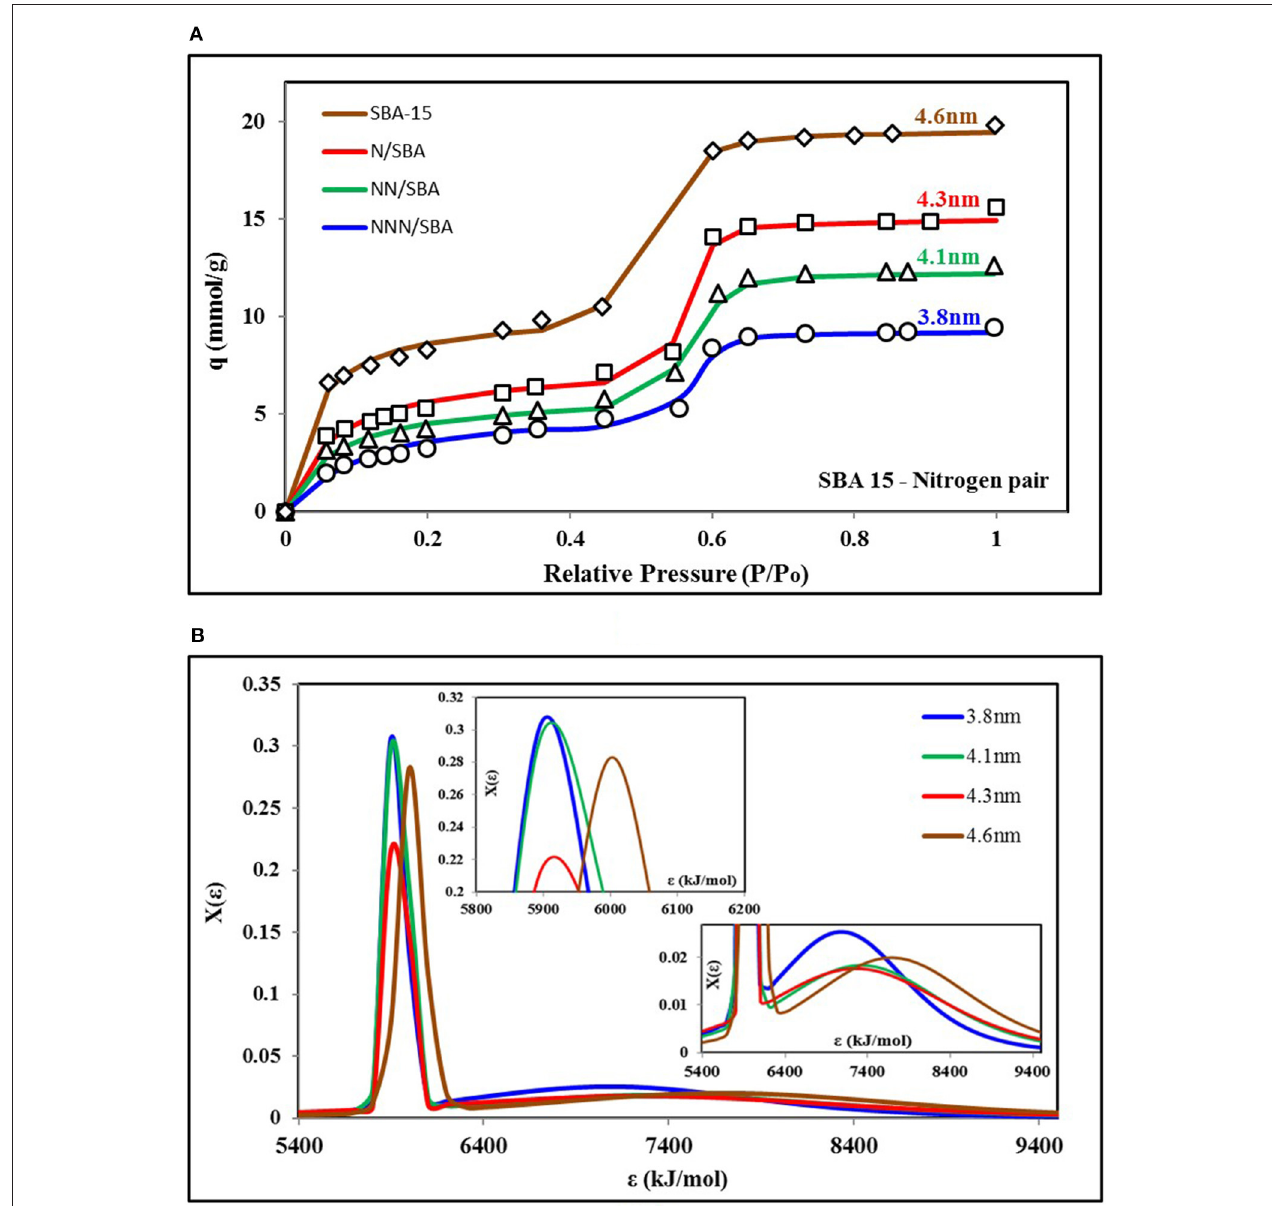
FIGURE 4 | (A) Isotherms and (B) adsorption sites energy distribution for SBA-15 variants paired with nitrogen as the adsorbate. The material is synthesized for pore expansion that resulted in a change in energy distribution for corresponding isotherms. Here, pore expansion caused an increase in smaller pores’ availability and expanded distribution of energy sites. However, surface heterogeneity doesn’t have any significant change.